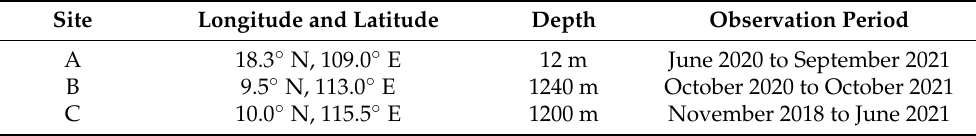
Table 1. Information on observation